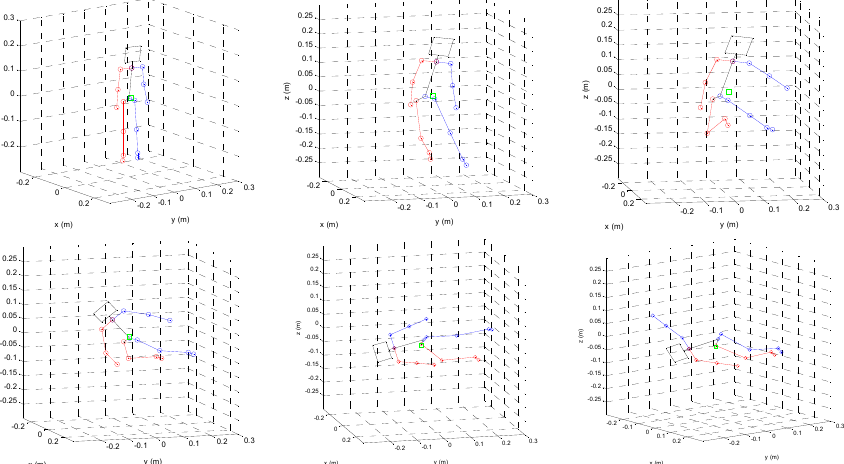
Figure 15. Results of the reconstructed 3D humanoid poses corresponding to Figure 13 (red line: right parts, blue line: left parts).